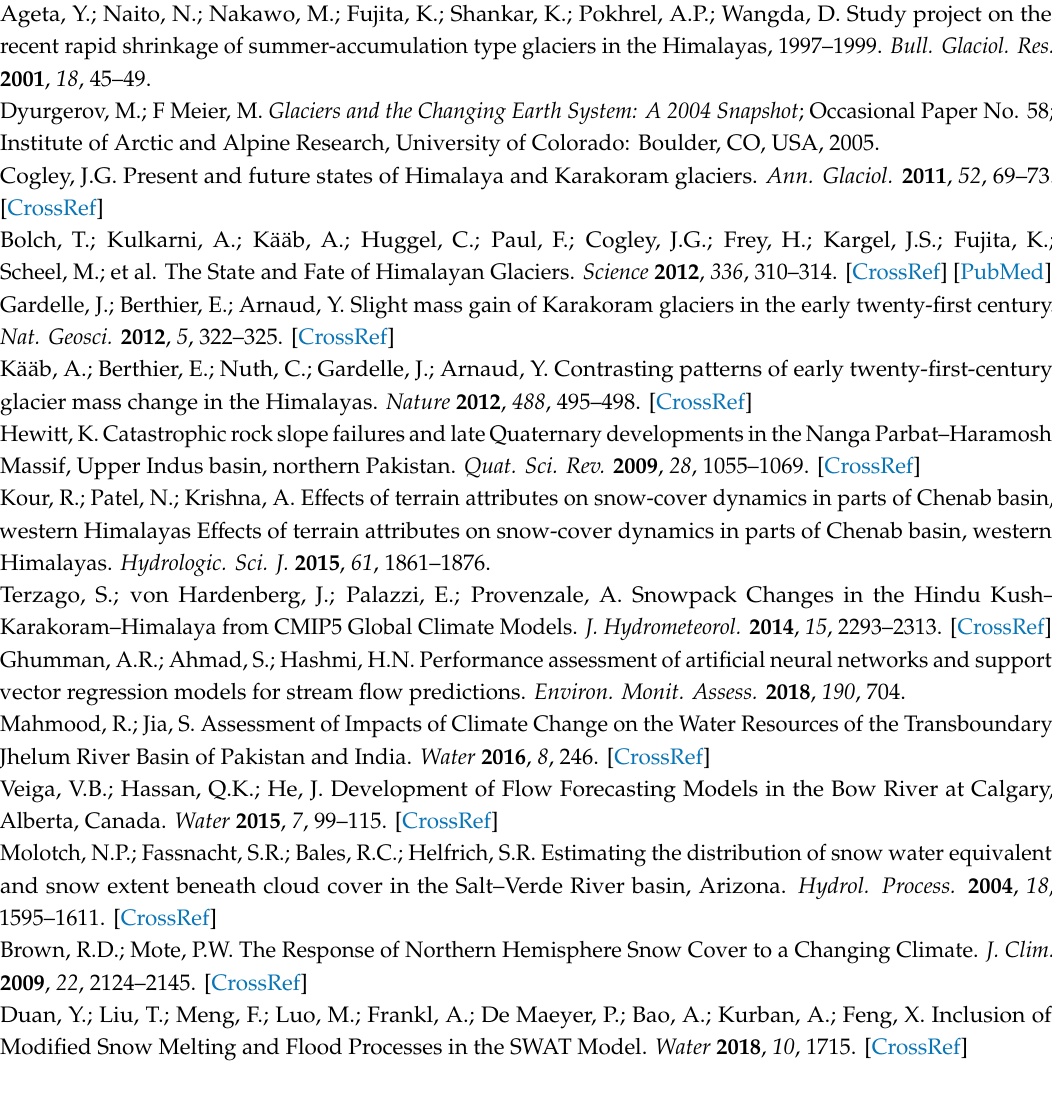
Figure S1: Mean monthly zonal temperature estimated from the available ground data using a lapse rate value for the (a) Astore and (b) Hunza basins, Figure S2: Mean monthly snow cover area estimated from the available MODIS images for the (a) Astore and (b) Hunza